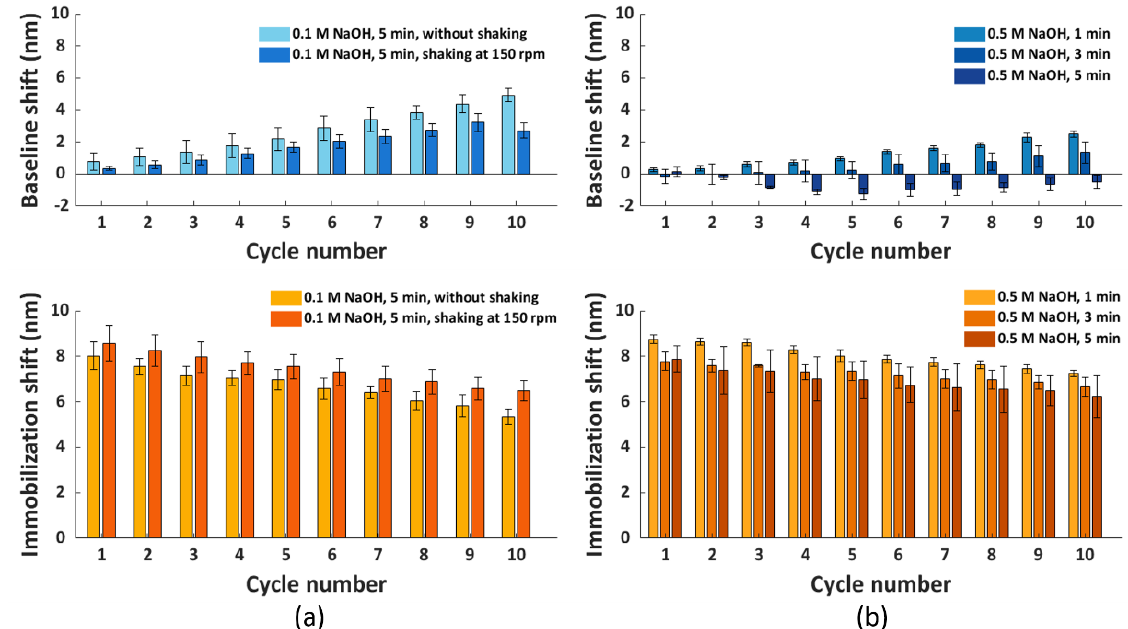
Figure 5. The baseline and immobilization shifts obtained for ten regeneration cycles, with His 6 –tagged scFv–33H1F7 immobilized at 20 µ g/mL in each cycle. The FO sensor probe surface regeneration was performed using condition G, combined with different washing conditions: ( a ) 0.1 M NaOH for 5 min with or without shaking at 150 rpm and ( b ) 0.5 M NaOH for 1, 3 or 5 min without shaking. Each bar represents the average value from two parallel measurements performed on two different FO sensor probes, with error bars being standard deviations (n s = 2).